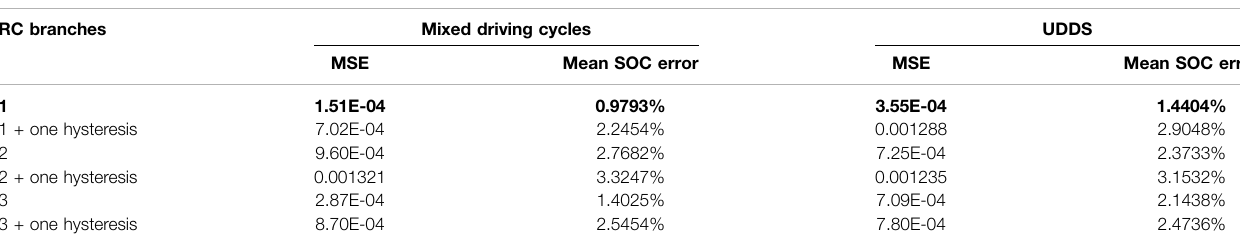
TABLE 12 | ACKF with 1% current bias noise added.